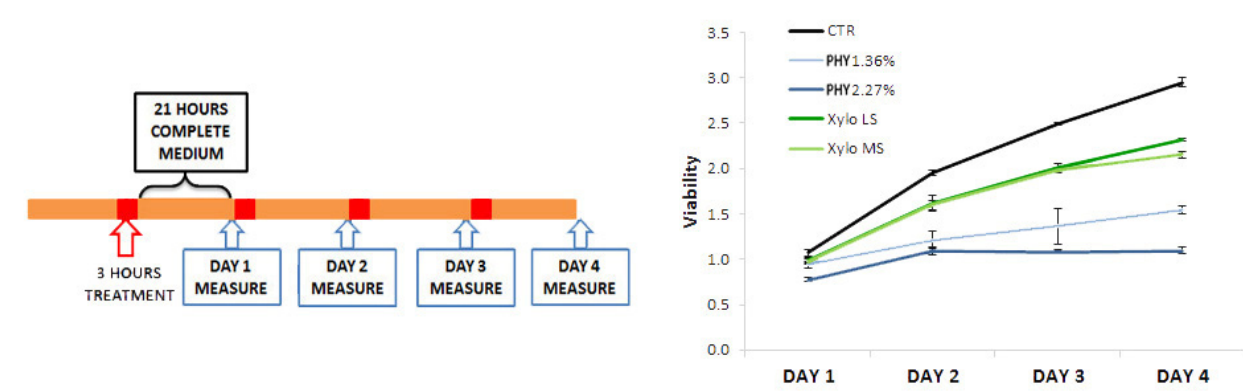
Figure 2. Cell viability over time. On the right: Schematic representation of the time-course viability assay. On the left: Graph represents mesothelial cell seeds on plastic viability assessed by MTS assay with or without different PD solutions at different time points. Dots represent mean ± standard deviation (error bars) ( n = 6 biological replicates).